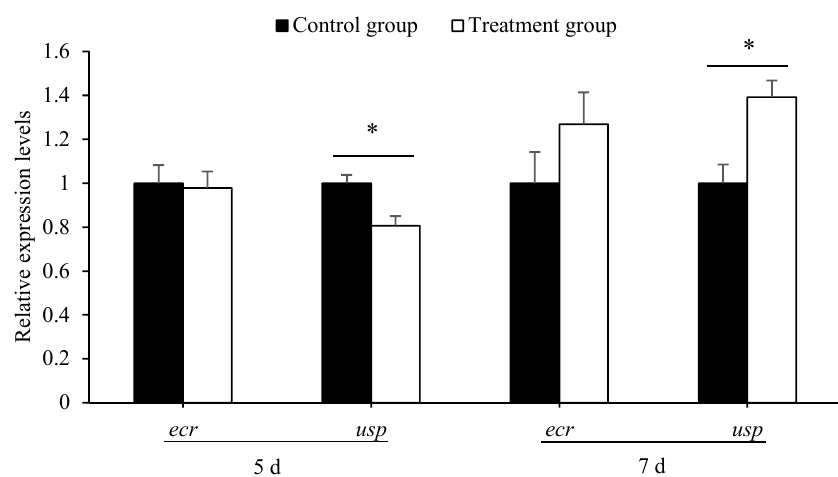
Figure 2. Antibiotics treatment effect on the expression of two development-regulation genes in 5- and 7-day-old A. mellifera larvae. The asterisk above the bars indicates a significant difference in gene expression level between the treatment and corresponding control (* for p < 0.05).